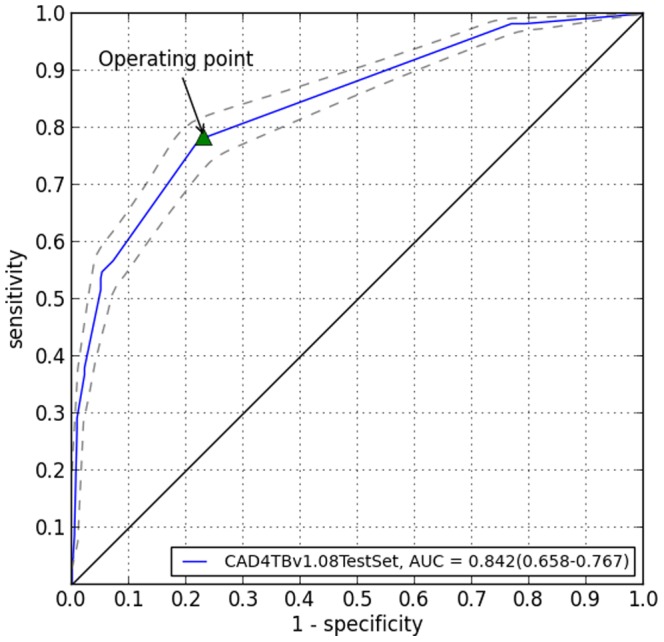
ROC on a test set of 969 CXRs.